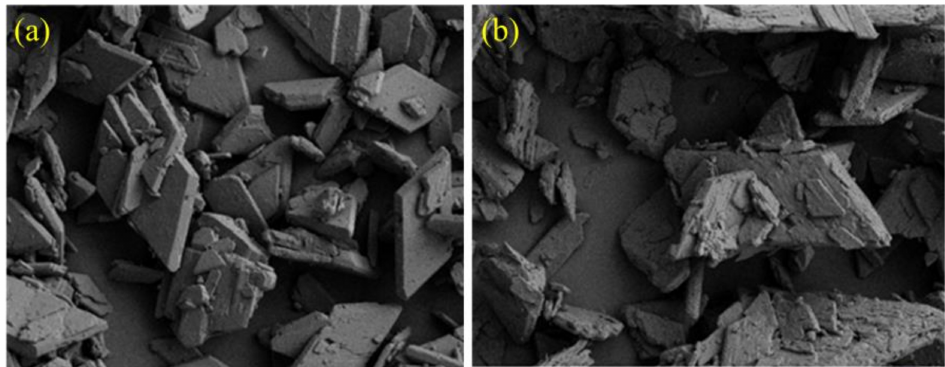
Figure 2. SEM morphology of RPG ( a ) and HPG ( b